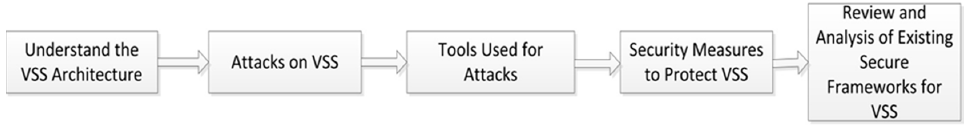
Figure 3. Roadmap of the paper.